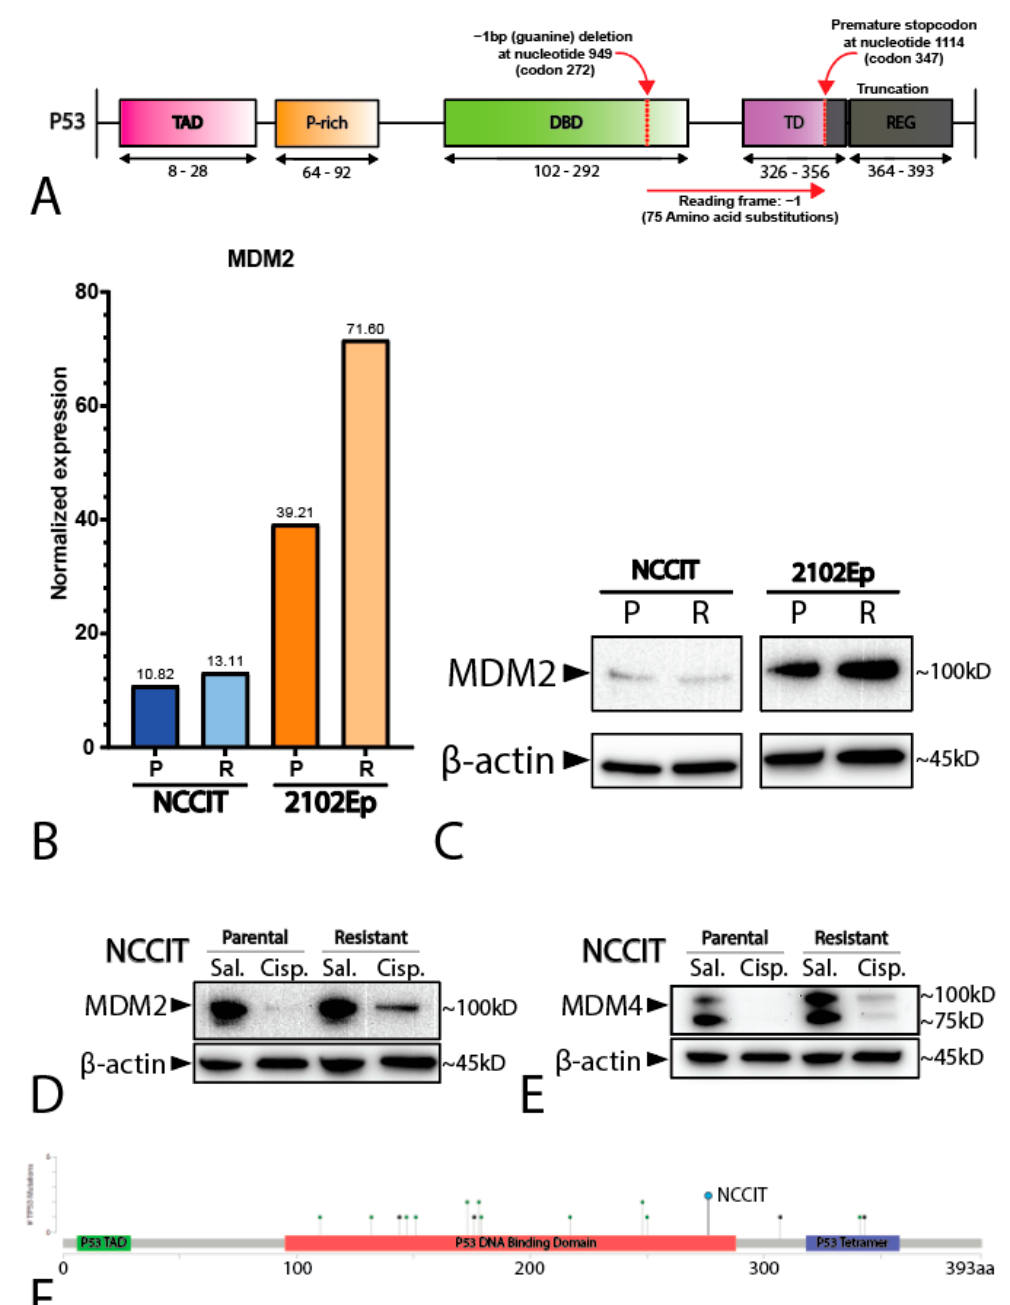
Figure 2. Characterization of the cell lines NCCIT and 2102Ep. ( A ) Schematic overview of the hemizygous mutation present in the NCCIT cell line. ( B ) Bar graph displaying the normalized expression (RNA-seq) of MDM2 in the NCCIT and 2102Ep parental and resistant cell lines. ( C ) Western blot showing the protein levels of MDM2 in the NCCIT and 2102Ep parental and resistant cell lines. ( D , E ) Western blot displaying the MDM2 ( D ) and MDM4 ( E ) protein levels after treatment with sublethal cisplatin doses (1 µM) or saline vehicle control. ( F ) Mutational position of TP53 mutations in patients in the MSKCC, J Clin Oncol 2016 data set. The mutation found in NCCIT is highlighted with a blue dot.